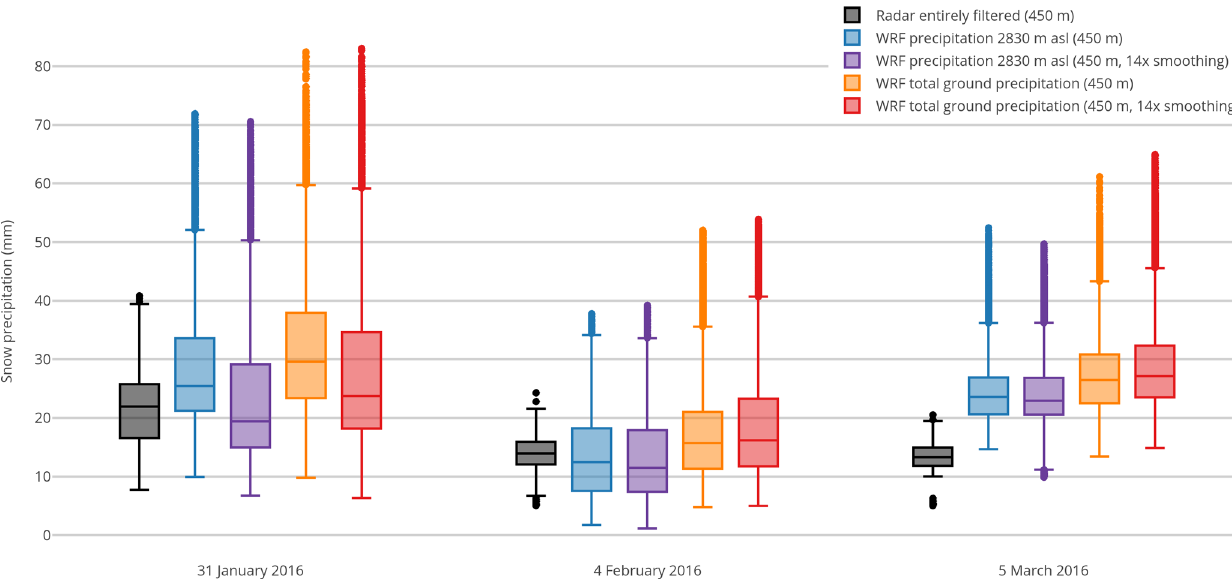
Figure 5. Domain-wide 24h precipitation statistics for the regional domain (450m resolution, Fig. 1) for the three precipitation events on 31 January, 4 February and 5 March 2016. Gray colors show entirely filtered radar precipitation. WRF precipitation at 2830m above sea level (ma.s.l.) for simulations with weak terrain smoothing (Sect. 2.1) and strong terrain smoothing are given in blue and violet, respec- tively. Orange (red) shows box plots of WRF total ground precipitation for weak (strong) terrain smoothing. Radar precipitation and WRF precipitation at 2830ma.s.l. are masked (as shown in Fig.